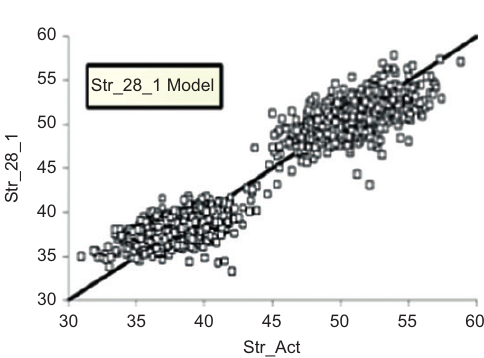
Figure 4 Calculated vs. actual values for the first model.